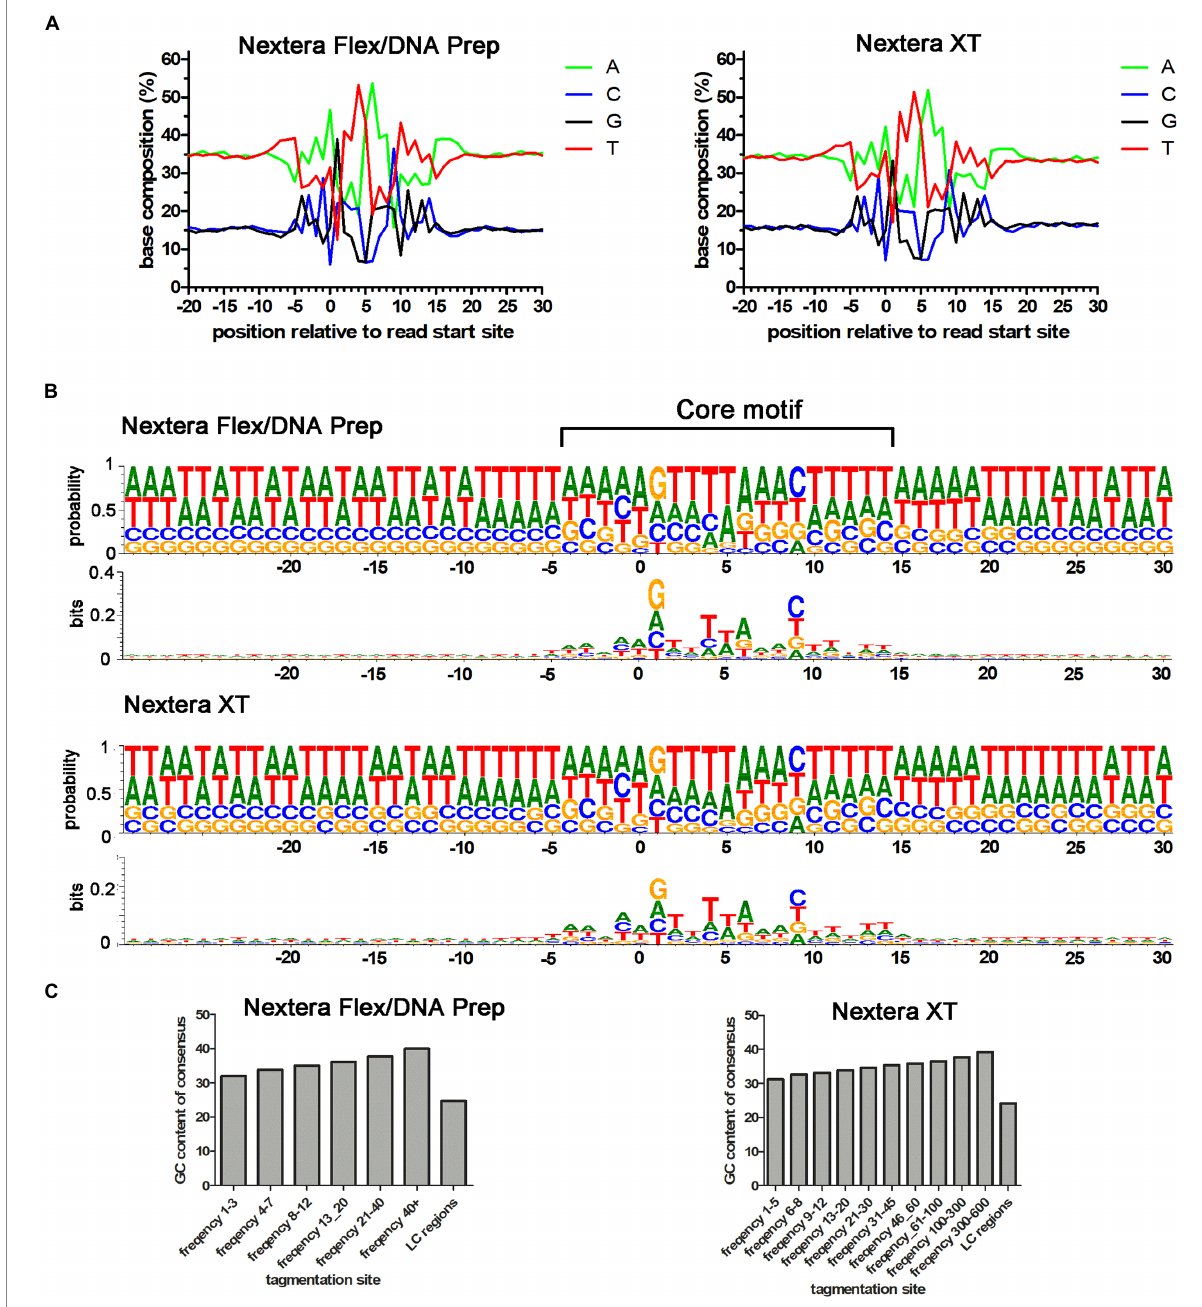
FIGURE 5 Base composition of Nextera tagmentation sites. (A) Average base composition of tagmentation sites relative to the read start position for the Nextera XT and Nextera Flex/DNA Prep data in the Campylobacter jejuni PT 28 dataset. (B) DNA Logo plot of the data shown in A. Both probability and bits indicating the importance of individual positions are plotted. (C) GC-content of the tagmentation sites when divided into groups of different cleavage efficiencies (higher usage frequency corresponds to higher cleavage efficiency). Note that the Nextera XT dataset had higher total coverage than the Nextera Flex/DNA Prep and therefore, the bins are set higher for that dataset. “LC regions” correspond to the tagmentation sites found in regions yielding low coverage when sequenced using Nextera XT, but the same regions were also analyzed in the Nextera Flex/DNA prep